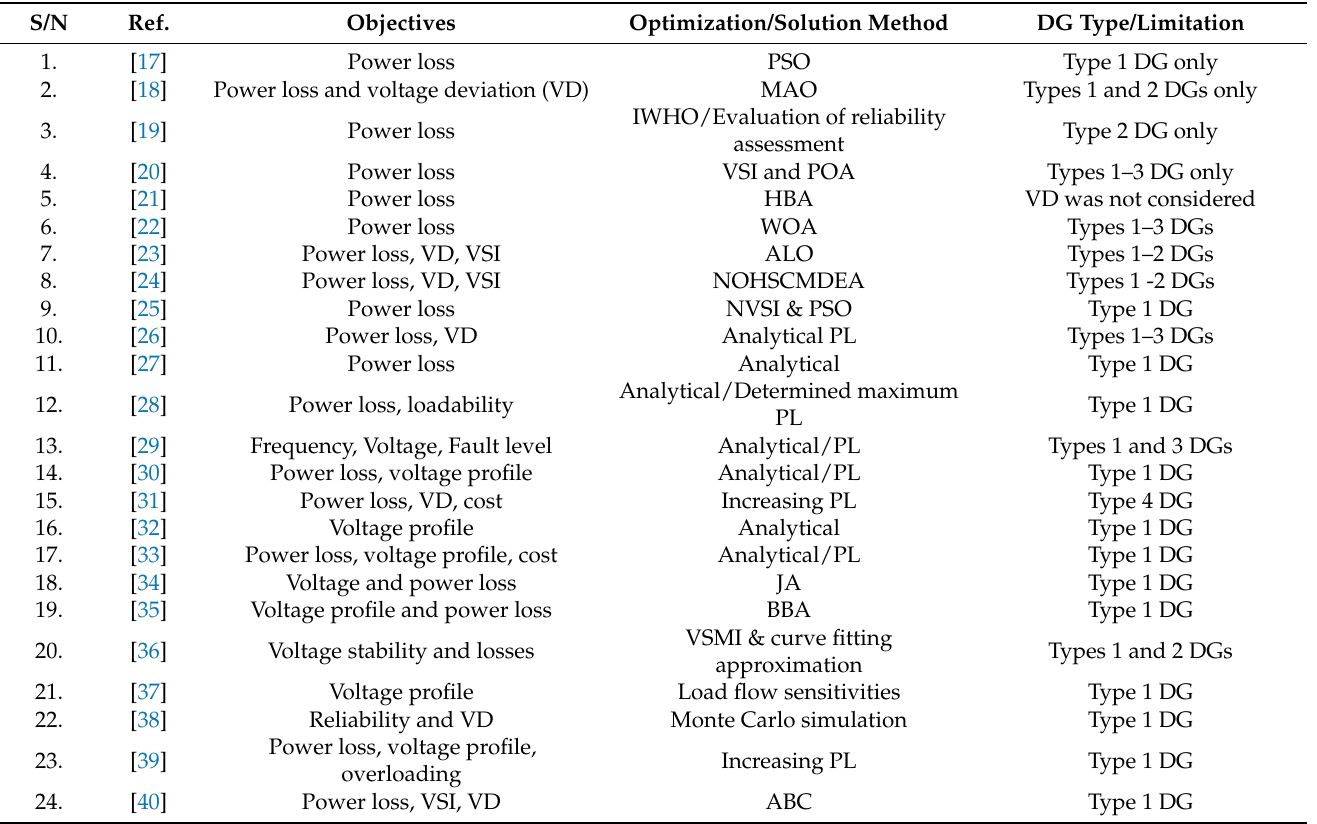
Table 1. Summary of Literature